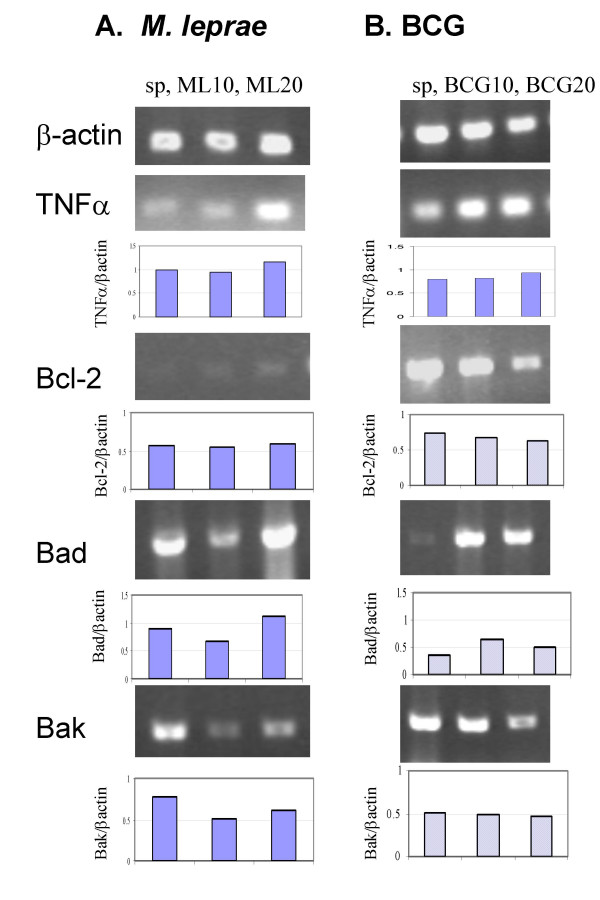
Mycobacterium-induced TNFα, Bcl-2, Bad and Bak gene expression. THP-1 cells were infected with M. leprae and BCG as described previously and total cellular RNA was extracted, reverse transcribed and PCR was carried out for β-actin, TNFα, Bcl-2, Bad and Bak genes. Gene expression was quantified using scanning densitometry. Panels illustrate gene expression in unstimulated cells 'sp', M. leprae 'ML10', 'ML20', and BCG 'BCG10' and 'BCG20' infected cells at 18 h post-stimulation in a representative experiment. Graphs illustrate expression of TNFα, Bcl-2, Bad and Bak mRNA relative to β-actin in each case.